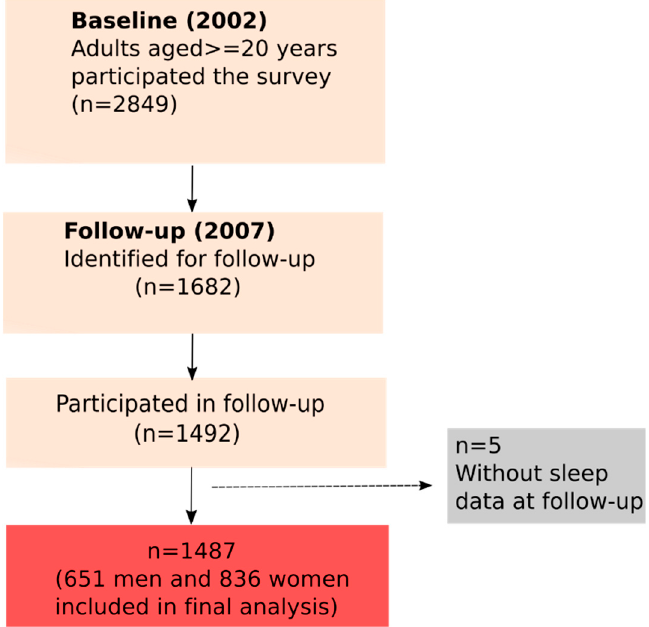
Figure 1. Sample description from Jiangsu Nutrition Study.